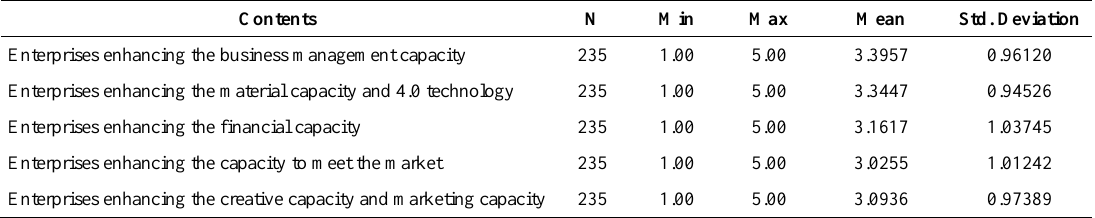
Table 6. Descriptive statistics from surveying 250 managers but 235 samples improving SMEs'